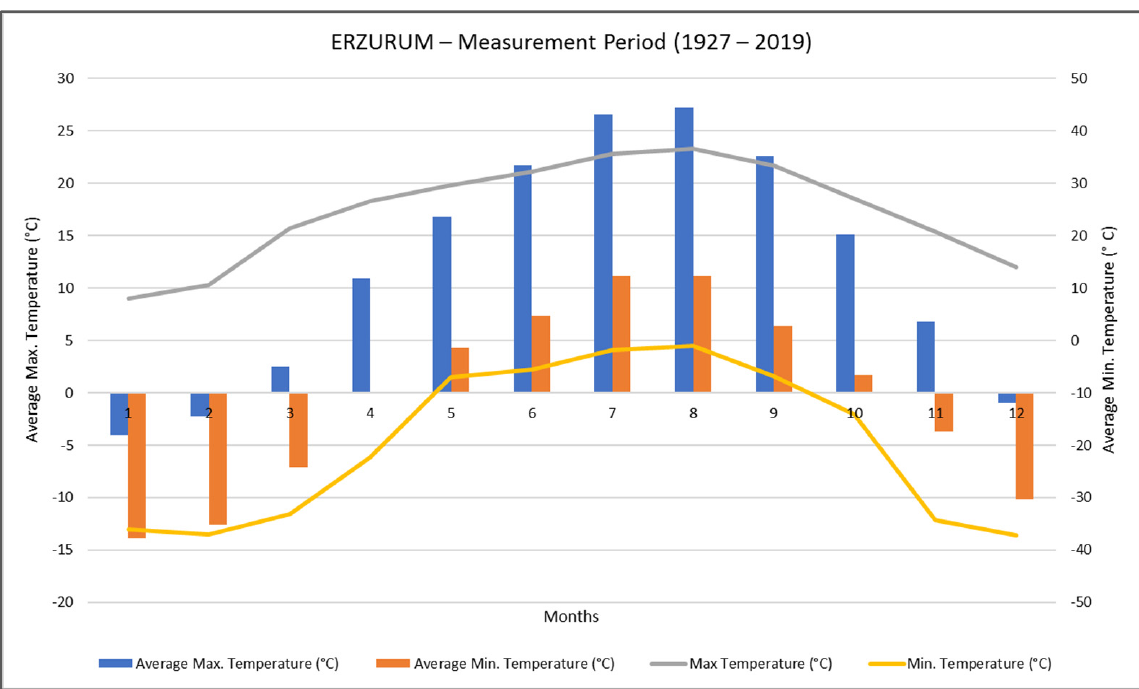
Figure 5. Annual temperature values of the Ankara (TSS 2021).